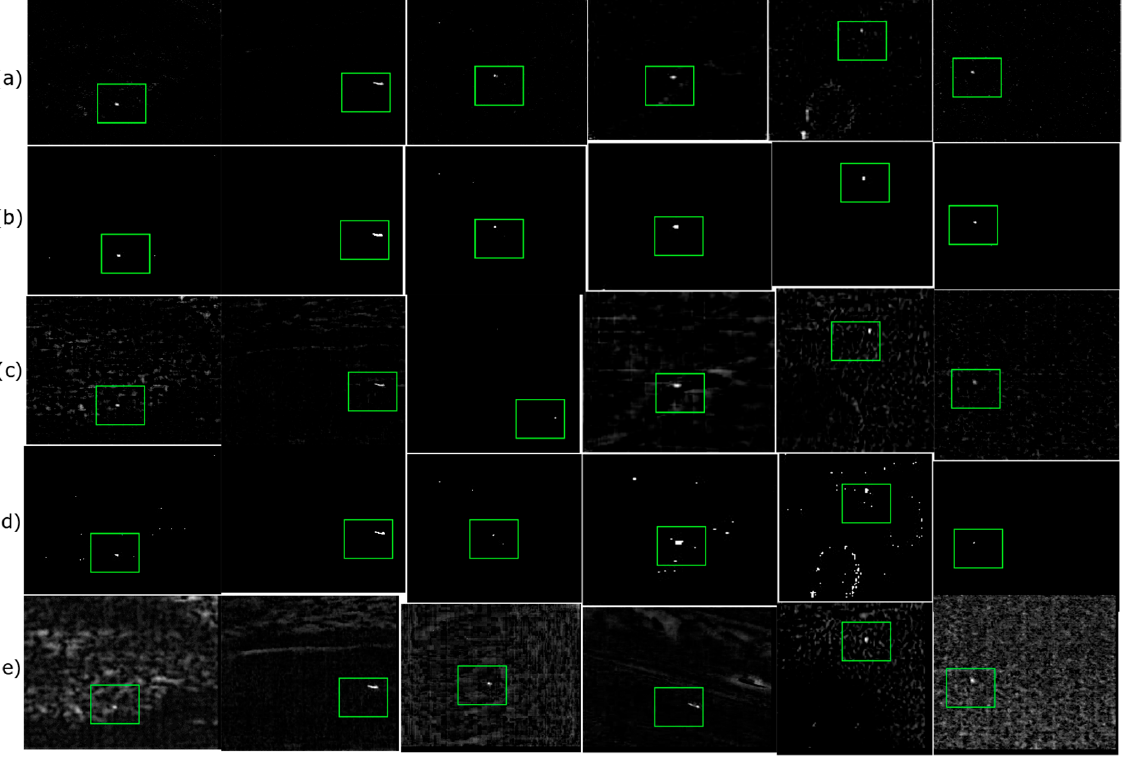
Figure 9. The target detection performances of the various methods on the image sequences presented in rows ( a – e ): ( a ) RPCA; ( b ) NIPPS; ( c ) RIPT; ( d ) NRAM; ( e ) our method. As a result, compared with existing baseline approaches, the suggested method not only suppresses the strong clutter background but it detects the small target better. The